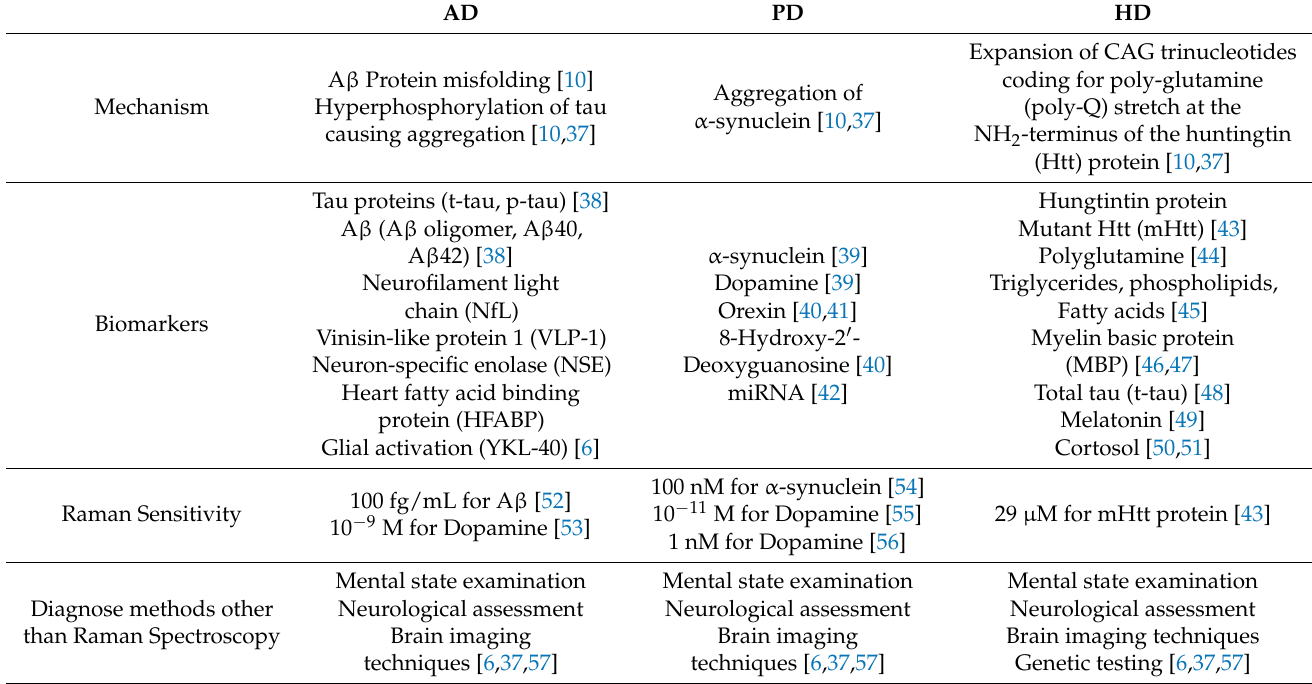
Table 1. Mechanisms, biomarkers, Raman sensitivity, and diagnose methods other than Raman spectroscopy for